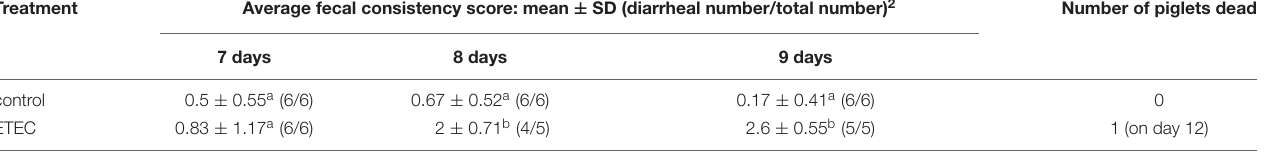
TABLE 2 | Fecal consistency score 1 of weaning piglets.